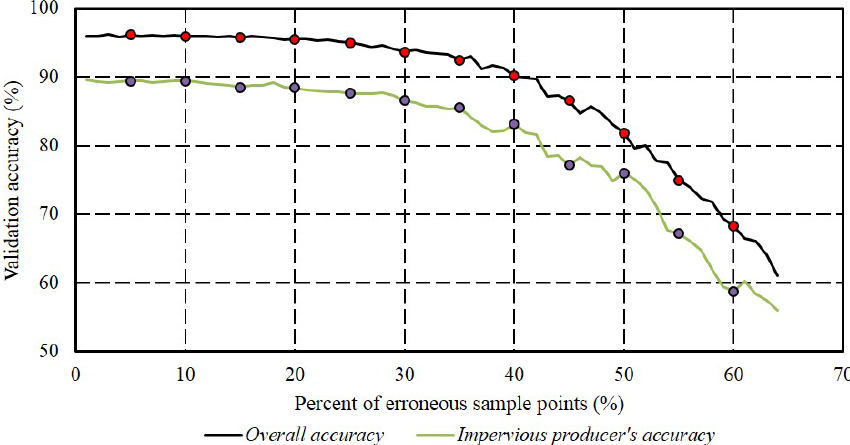
Figure 10. Sensitivity analysis showing the relation between the classification accuracy and the percentage of erroneous samples